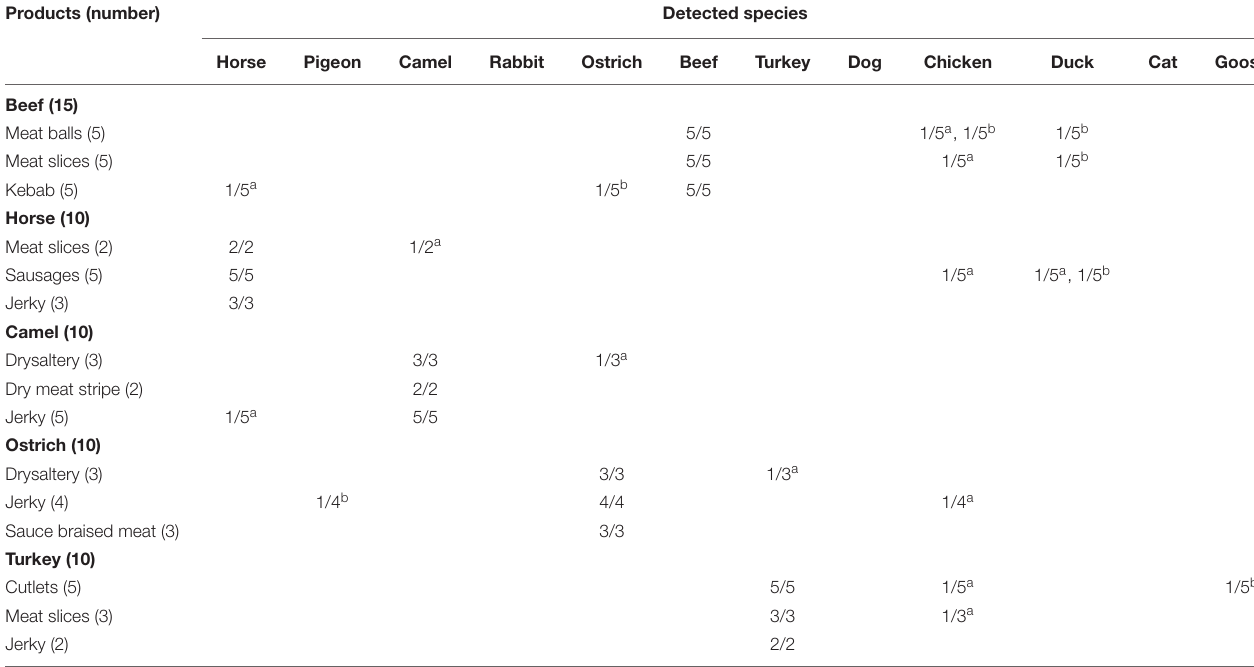
TABLE 2 | Results of multiplex PCR assay performed on commercial meat products. Products